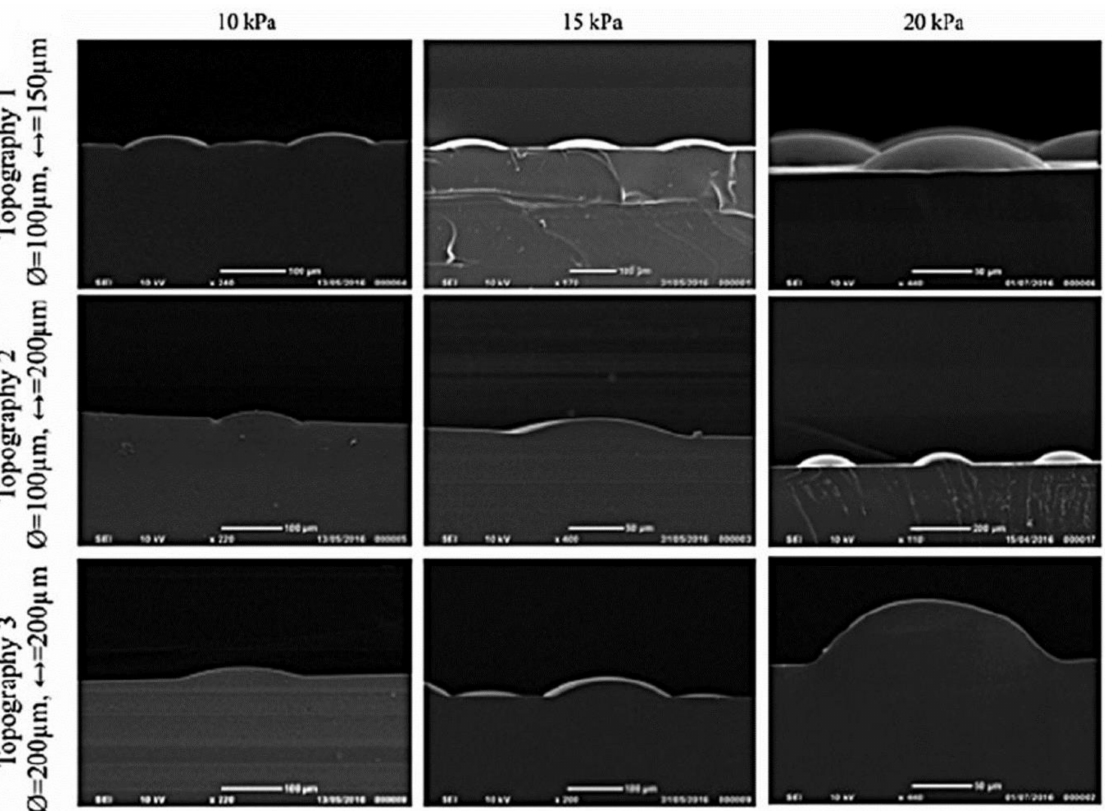
Figure 4. SEM of PDMS stamp depicting PLGA deformation by vacuum pressure. Deformation as a function of topography (1–3) and vacuum pressure (10, 15, or 20 kPa) are investigated. Photo reused with permission [114] © 2019 Tissue Engineering: Part A, Mary Ann Liebert,